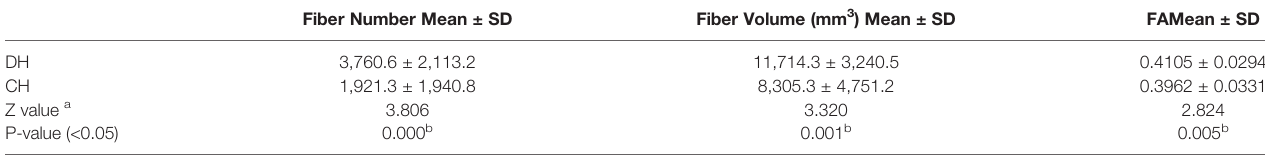
TABLE 3 | Comparation of DTT metrics between dominant and contralateral hemisphere.